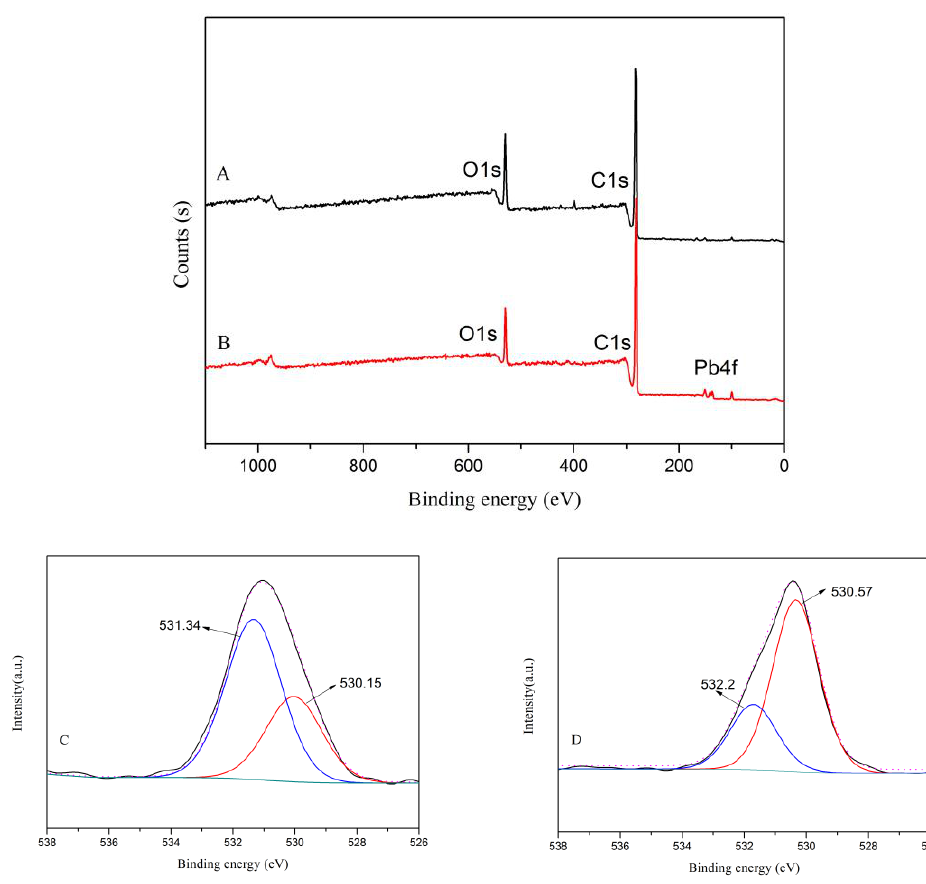
Figure 10. The typical XPS wide scan spectra of CLNPs before ( A ) and after ( B ) Pb(II) adsorption. O1s spectra of CLNPs before ( C ) and after ( D ) Pb(II) adsorption.